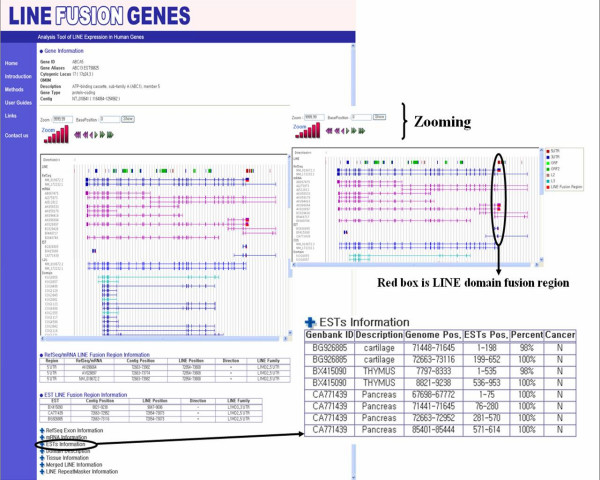
Part of output from LINE FUSION GENES. LINE FUSION GENES shows evidence of and information about expressed LINE events within genes. Both the LINE fusion regions and transcript information are shown in tabular form and a graphic view represents the family, orientation, structure and length of the LINE. This view provides more information such as the tissue distribution of the genes, merging LINE elements as evidence of their expression, and domain information related to LINE expression.